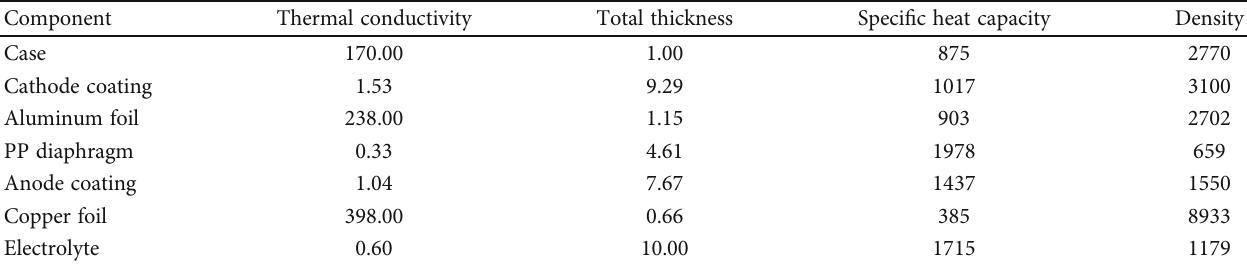
Table 3: Thermal parameters of each component of the battery.